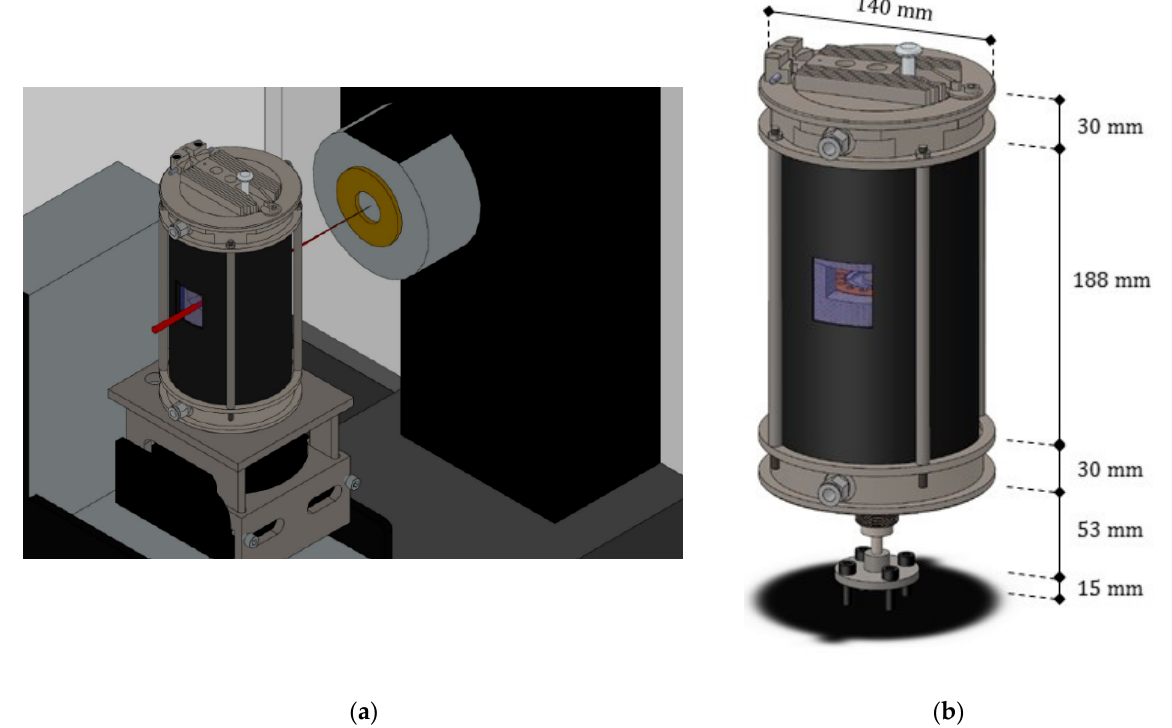
Figure 2. ( a ) Axonometric view of the furnace positioned within the cabinet, with a pictorial representation of the X-ray beam (colored in red) emitted by the tube; ( b ) enlarged view of the prototype, with overall dimensions.